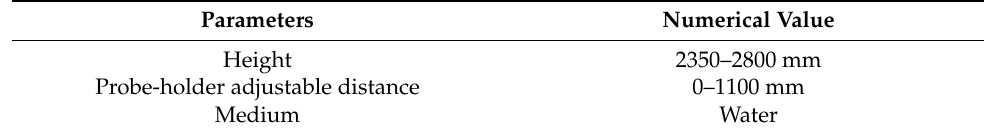
Table 1. Primary parameters of probe-error-correction platform.